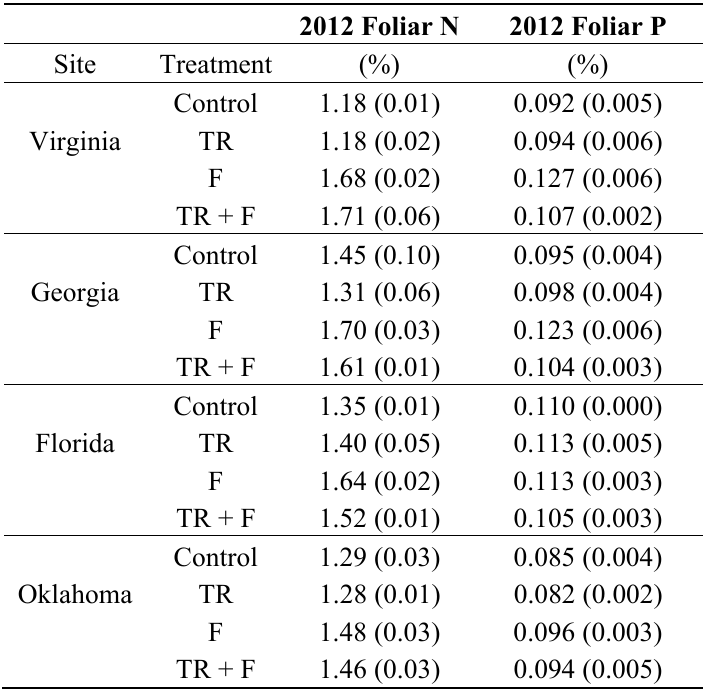
Table 5. Dormant season measurements of foliar nitrogen (N) and phosphorus (P) concentrations one year after treatment initiation. TR = throughfall reduction treatment, F = Fertilization treatment. Numbers in parentheses are standard